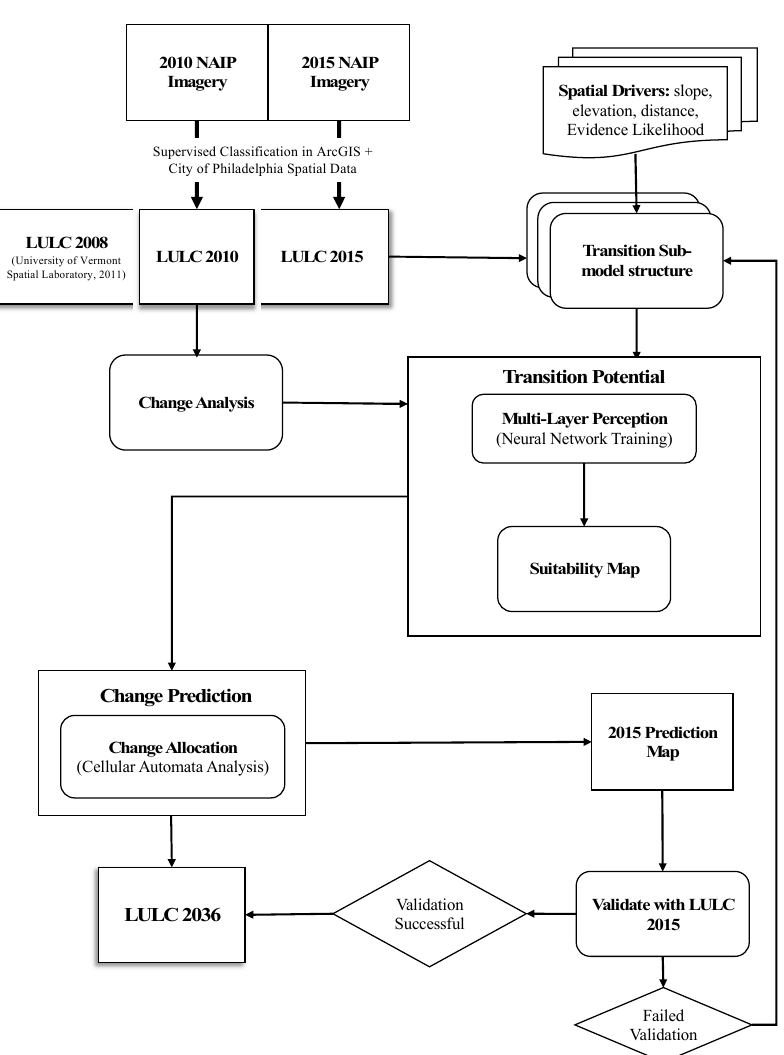
Figure 2. Processes involved in the Land Change Modeler (LCM) to create and validate the 2036